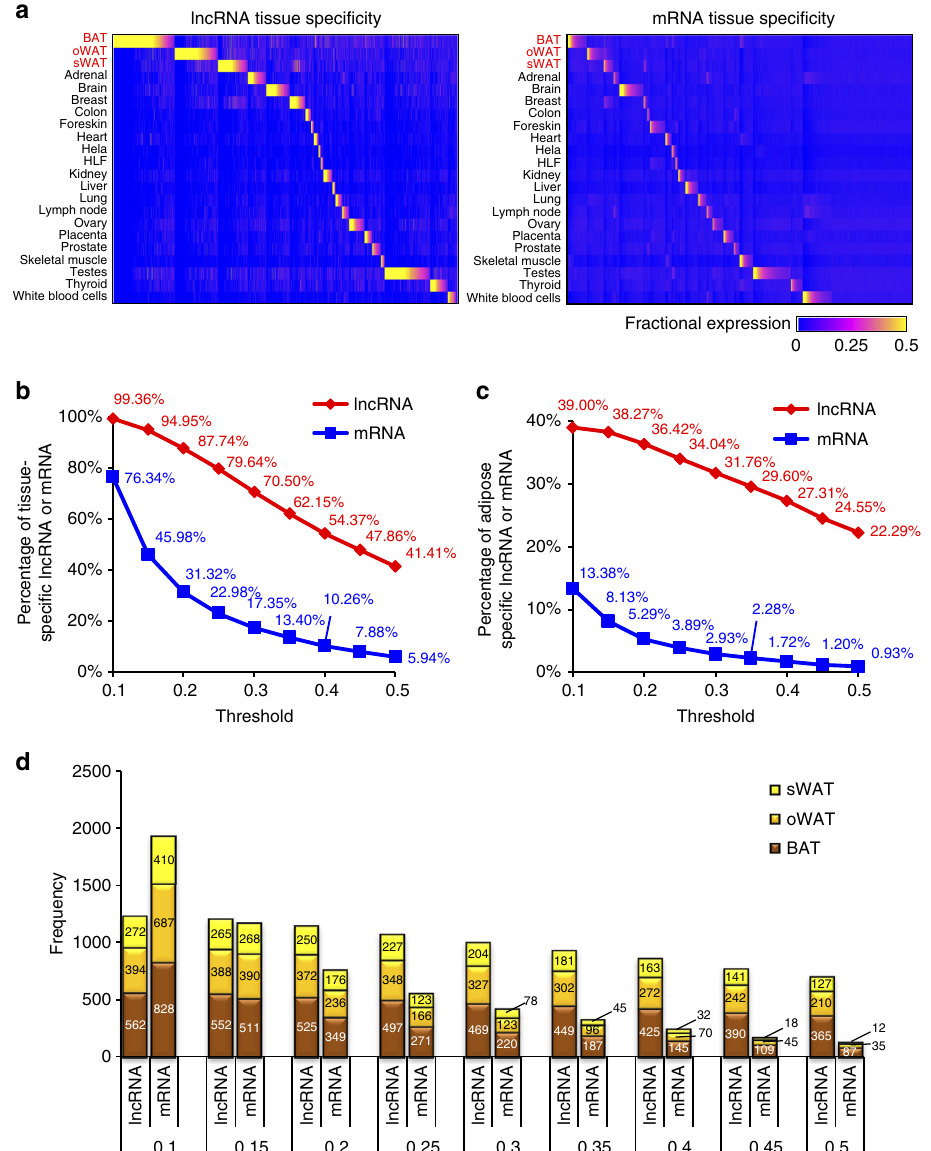
Fig. 2 Tissue speci fi city of human adipose lncRNAs. a Relative abundance of 14383 adipose-expressed mRNAs (rows, left panel) and 3149 lncRNAs (rows, right panel) across 22 examined tissues (columns). Color density represents the fractional expression of each lncRNA in each tissue relative to all examined tissues. b Percentage of tissue-speci fi c lncRNAs and mRNAs under varying thresholds of fractional expression (step size 0.05). Tissue-speci fi c transcripts in any of the 22 tissues were considered in this analysis. c Percentage of adipose-speci fi c (BAT, oWAT, or sWAT) lncRNAs and mRNAs under varying thresholds of fractional expression (step size 0.05). Tissue-speci fi c transcripts in any of the three adipose tissues were considered in the analysis. d Number of adipose-speci fi c lncRNA and mRNA at varying thresholds. Tissue-speci fi c transcripts for any of the three adipose tissues were considered in the